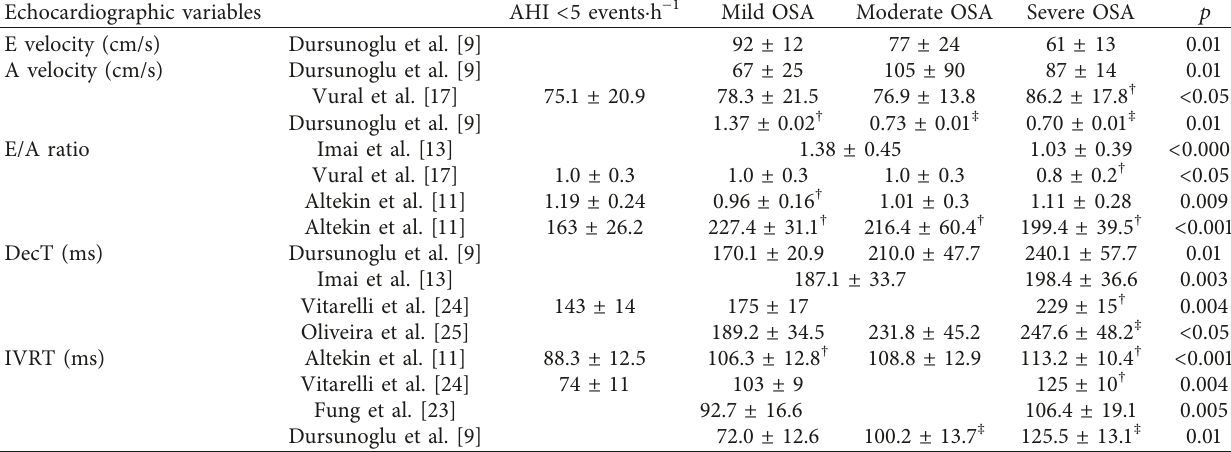
Table 4: Left ventricular diastolic function in relationship with OSA severity. Echocardiographic variables